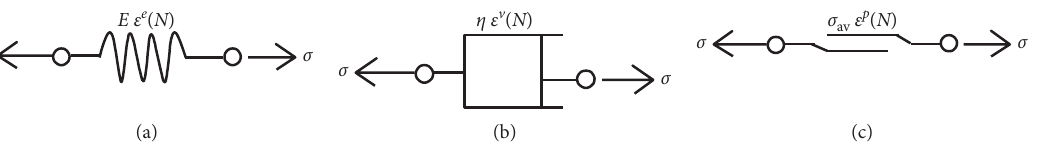
Figure 2: One-dimensional fatigue element [42].